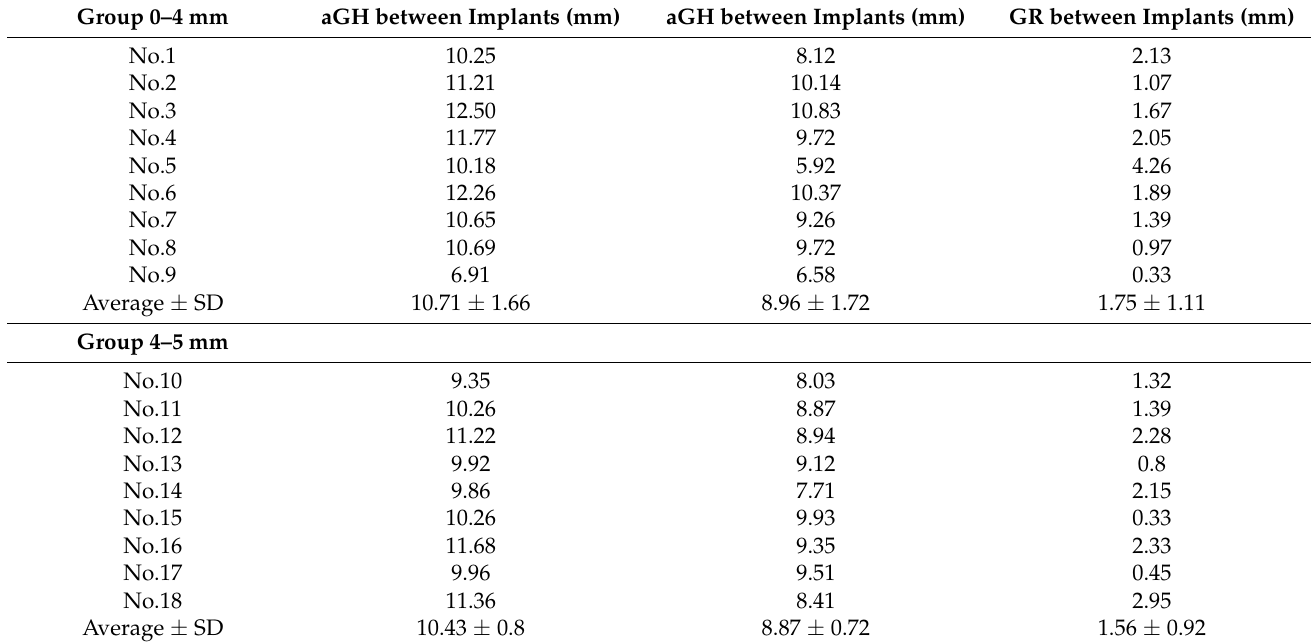
Table 2. CBCT Measurement of the site between